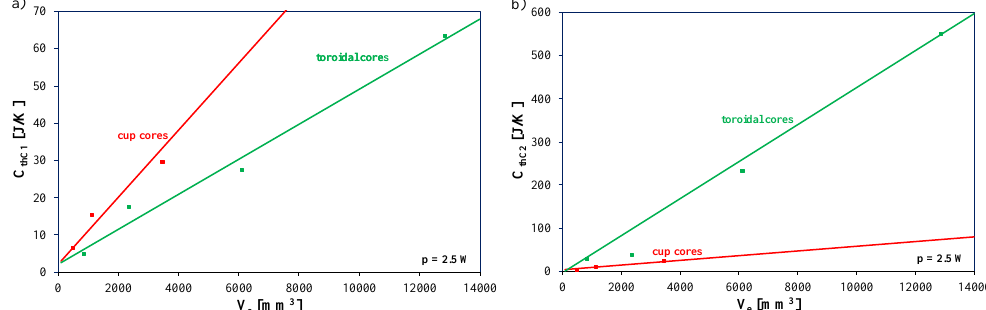
Figure 18. Measured and calculated dependences of selected thermal capacitance of the core C thC 1 ( a ) and C thC 2 ( b ) on the effective volume of the core for inductors with cup cores and toroidal cores. As can be observed, the considered dependences are increasing functions. It is worth noticing that the thermal capacitance C thC 1 of the tested inductors is smaller for inductors including toroidal cores, whereas the thermal capacitance C thC 2 is smaller for inductors including cup cores. Also, the good agreement between the results of measurements and calculations was obtained. The differences between these results do not exceed 12% for both considered shapes of cores. 5. Conclusions In the paper, a compact nonlinear thermal model of the inductor was proposed. This model makes it possible to calculate values of temperature of the core and the winding of the inductor taking into account occurrence of self-heating in every mentioned component of the inductor and mutual thermal couplings between the core and the winding. It also takes into account the influence of power dissipated in every component of the inductor on thermal resistance of the core and the winding and mutual thermal resistance between the core and the winding. A manner of calculating the value of parameters of this model was also proposed.